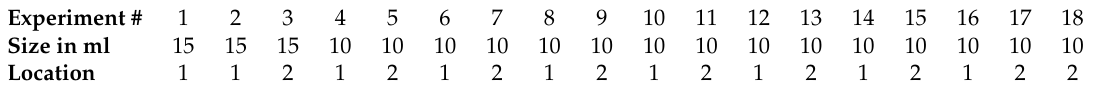
Table 1. Summary of experiments: Inoculum size in ml and experiment location are shown.